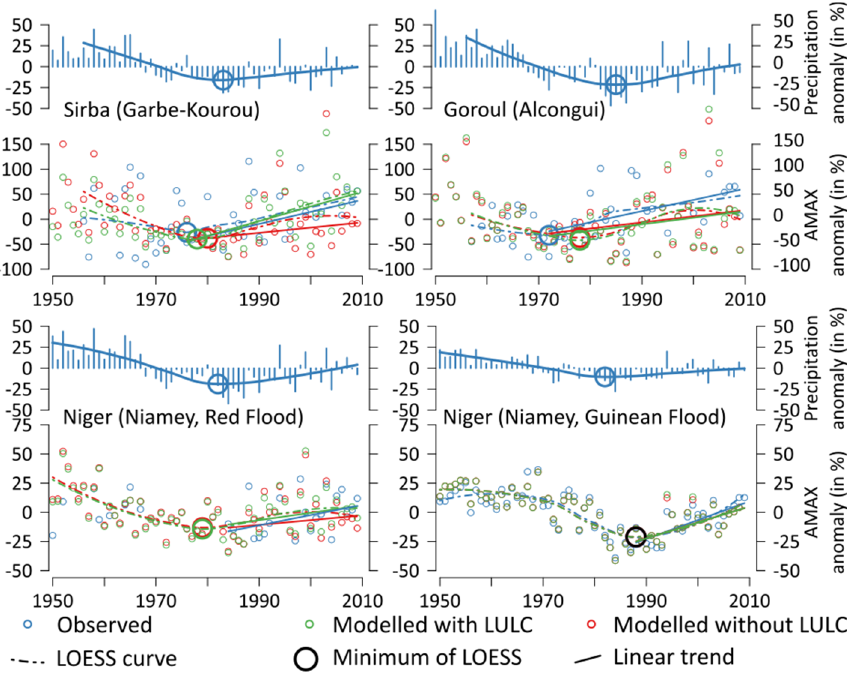
Figure 9. Anomalies of annual maximum discharges for the gauging stations Alcongui (Goroul River), Garbe-Kourou (Sirba River) and differentiated between the Red and the Guinean Flood for Niamey (Niger River). On the top of each region, rainfall anomalies over the respective catchment are plotted. A LOESS curve with a minimum point is added as a dashed line and the Theil-Sen estimators for the discharge trends are plotted as bold lines, beginning at the minimum of the observed discharge points. Please note that, for the observed values of the Red Flood at Niamey, the time series is incomplete (see Section 2.4.2). Therefore, the LOESS curve is not plotted and the trends start at 1984 (see Section 2.6). For the Guinean Flood at Niamey, all minima are on the same point and the circle is plotted in